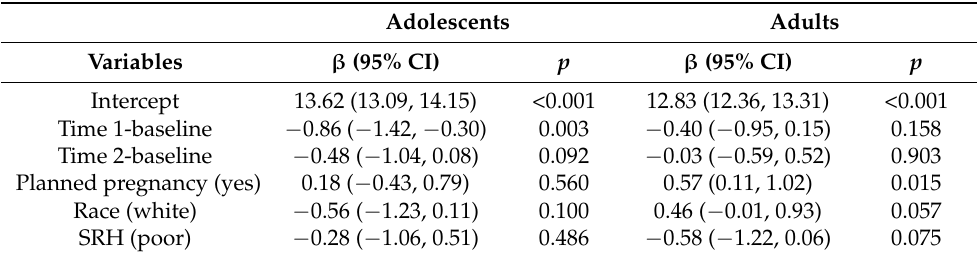
Table 5. Multivariate mixed-effects regression for longitudinal effects of independent variables on THB trajectory for stratified sample by age ( n = 100). Adolescents